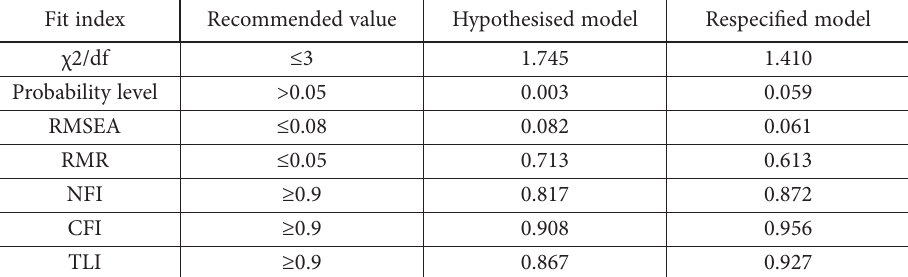
Table 2. Goodness-of-fit statistics of the hypothesised and respecified models (source: created by authors) Fit